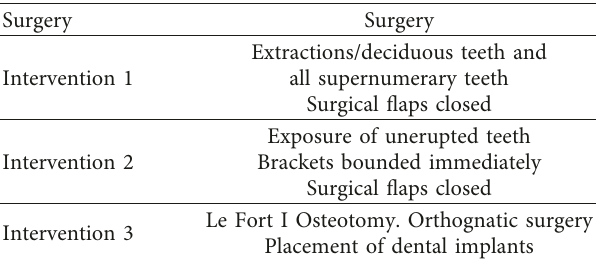
Table 5: Surgical-prosthetic approach (Bronx).